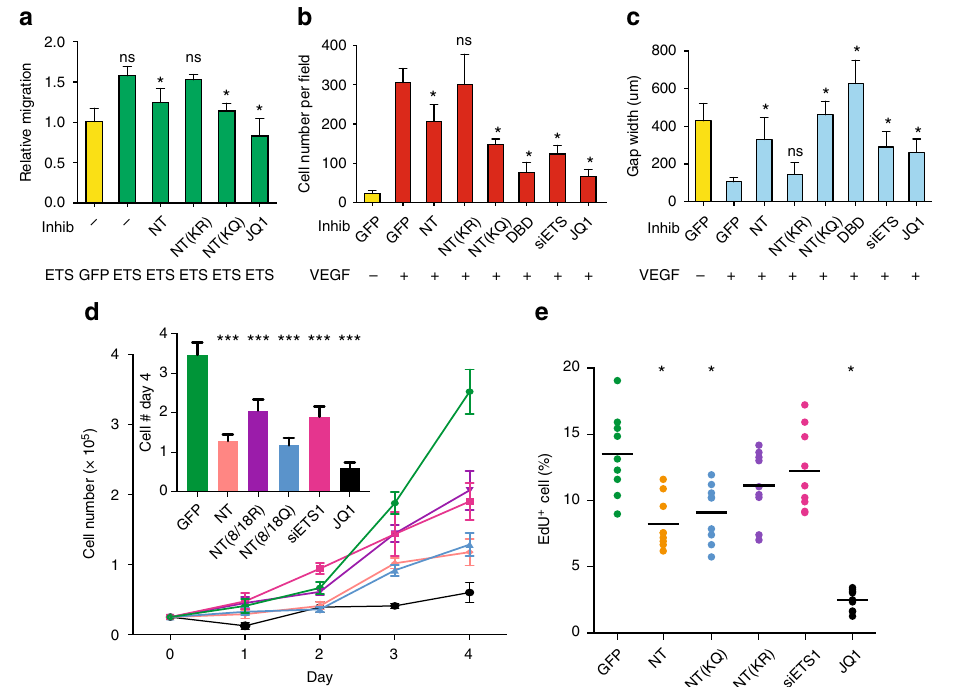
Fig. 6 ETS1 – BRD4 interaction is required for VEGF-driven angiogenic responses in vitro. a ETS1-driven EC migration was inhibited by interfering with BRD4- mediated RNAPII pause release or ETS1 – BRD4 interaction. HUVEC cells were transduced with the indicated lentivirus, or treated with JQ1, and migration was measured using a trans-well assay. ETS1 stimulated migration, and this was attenuated by peptides that block ETS1 – BRD4 interaction or by JQ1 inhibition of BRD4. b VEGF-driven EC migration was inhibited by interfering with BRD4-mediated RNAPII pause release or ETS-BRD4 interaction. Trans well assay was performed as in a . VEGF was used at 30 ng ml − 1 . Student ’ s t test vs. VEGF-stimulated cells without inhibitor: * p < 0.05. ns : not signi fi cant, n = 4. Bar = 250 µ m. c VEGF-driven wound healing of HUVEC monolayer was inhibited by interfering with BRD4-mediated RNAPII pause release or ETS1 – BRD4 interaction. The width of the scratch at the end of the culture period is inversely related to EC migration capacity. Student ’ s t -test vs. VEGF- treated cells without inhibitor: * p < 0.05. n = 3. ns , not signi fi cant. d , e HUVEC proliferation requires ETS1 – BRD4 interaction and BRD4 activity. HUVECs were transduced with lentivirus expressing the indicated proteins, transfected with siRNA, or treated with JQ1. Cells were cultured in EGM2 growth medium. Cell number was counted daily c , or traversal of S phase was measured by culturing cells in the nucleotide analog EdU ( e ). Cell counts at day 4 are plotted in the inset in c . Bar graphs show mean ± s.d. Intergroup comparisons were made with Student ’ s t -test vs. baseline ( yellow , a – c ; green , d , e ): * p < 0.05; *** p < 0.001; ns , not signi fi cant. For each experiment, n =